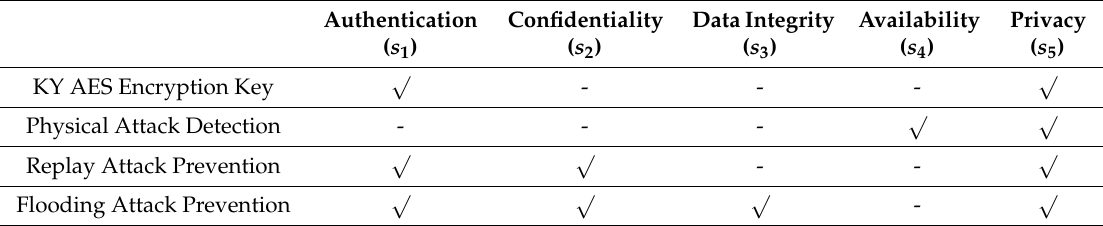
Table 7. Mapping table of security solution with security parameter.